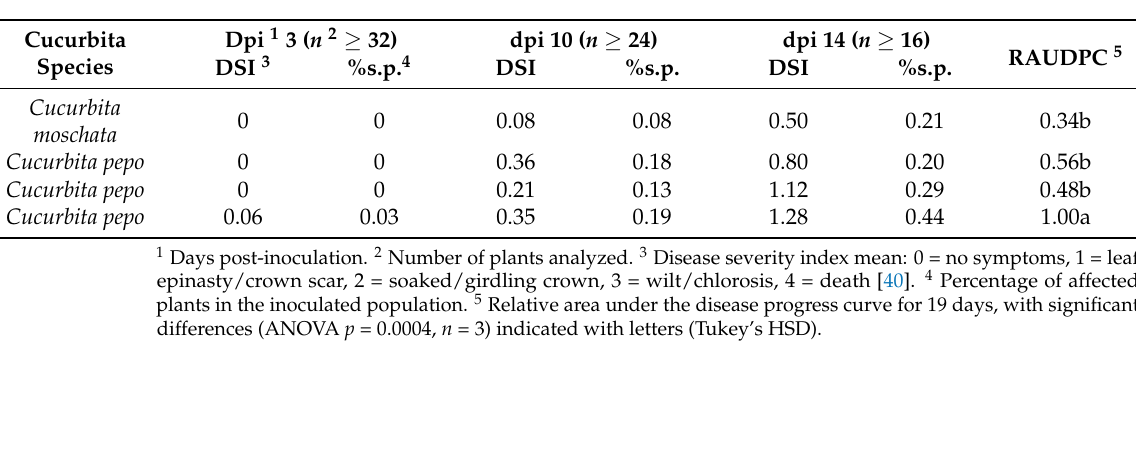
Figure 3. Randomly selected plants for the sample collection of the gene expression analysis 14 days post-inoculation. A total of eight roots and eight crowns per genotype for each non-inoculated ( 1 ) and inoculated ( 2 ) sample were collected from four pots (two plants/pot). Plants were inoculated with P. capsici . The symptomatology severity was higher in MUCU-16 ( 2 , right) than that for the rest of the genotypes, although the damage was not homogeneous for all individuals. Table 4. Phytophthora capsici disease evolution in M3 mutant families.